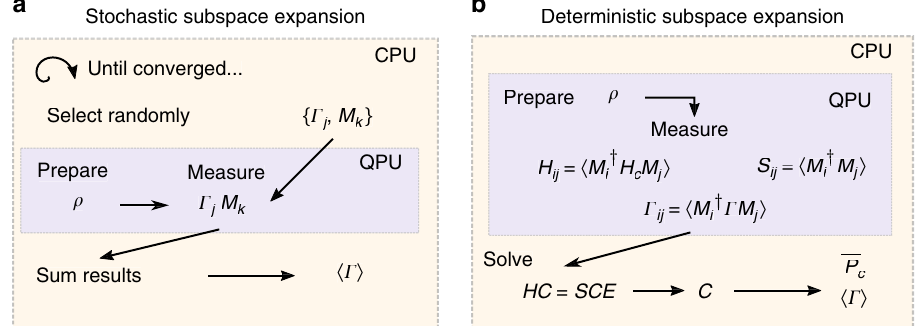
Fig. 1 Algorithmic schematics of the stochastic and deterministic subspace expansions. The goal is to use an expansion in a subspace around a prepared quantum state, ρ , to improve the expected value of the logical observable 〈 Γ 〉 , without requiring ancilla based syndrome measurements or feedfoward. An observable in the logical space Γ is expressed as a sum of Pauli operators, Γ k , while symmetries, M k , either naturally dictated by a system or from the stabilizer group S are selected. In the stochastic case ( a ), the state ρ is re-prepared many times, and these measurements are used to assemble the corrected expectation value 〈 Γ 〉 by expanding the averaged result in the resulting subspace. In the deterministic case ( b ), we may expand the set of M k to include non-symmetries, and the corresponding averages over ρ are evaluated with many repetitions to form the representations of the operators in the subspace around ρ . These matrices de fi ne an of fl ine generalized eigenvalue problem whose solution, C , de fi nes both an optimal projector in the basis of operators M i , P c and corrected expectation values 〈 Γ 〉 for desired observables. We note that a scheme for including recovery operations can be found in the methods